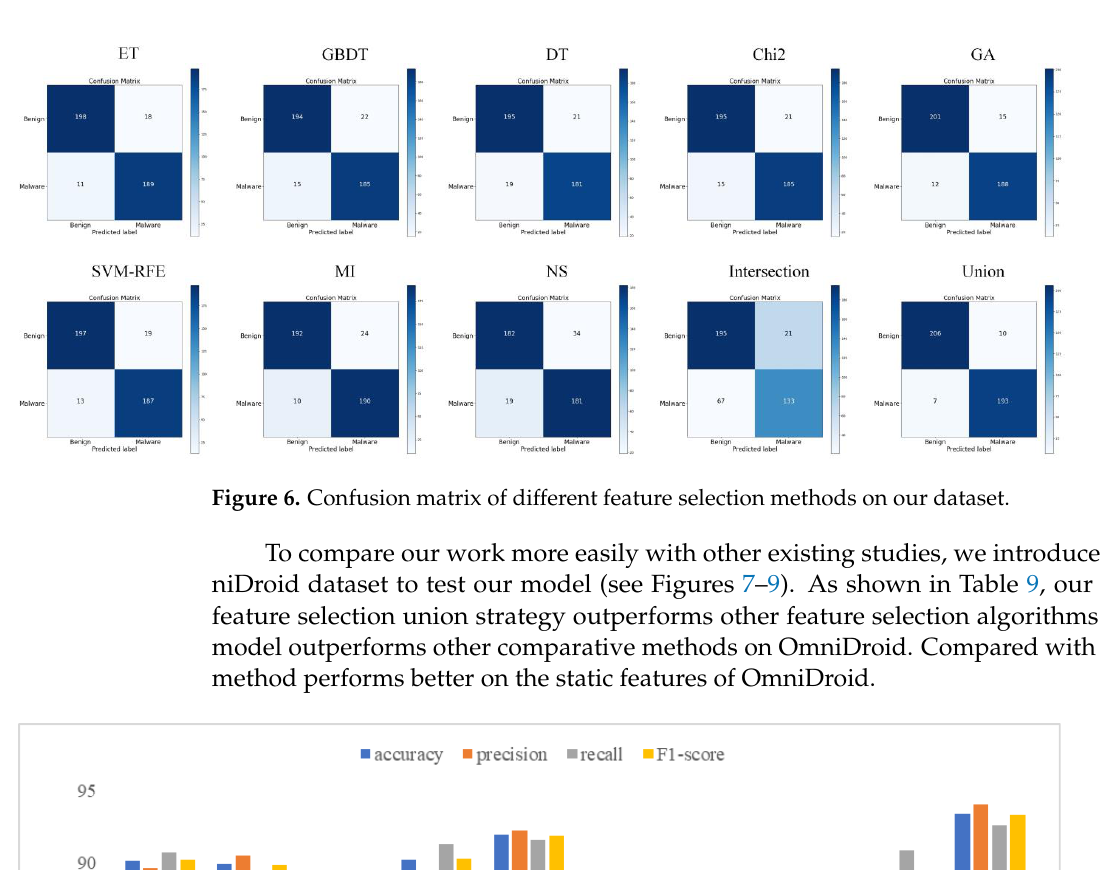
Figure 7. Feature selection results comparison on OmniDroid dataset.